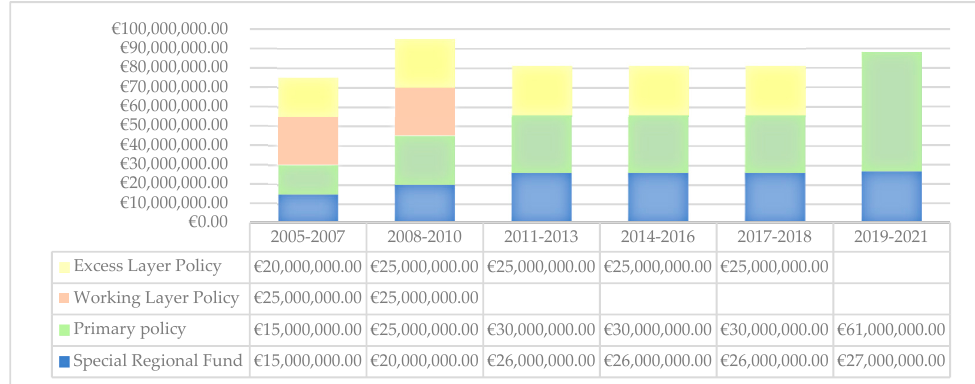
Figure 3. Maximum amount for total claims per year.